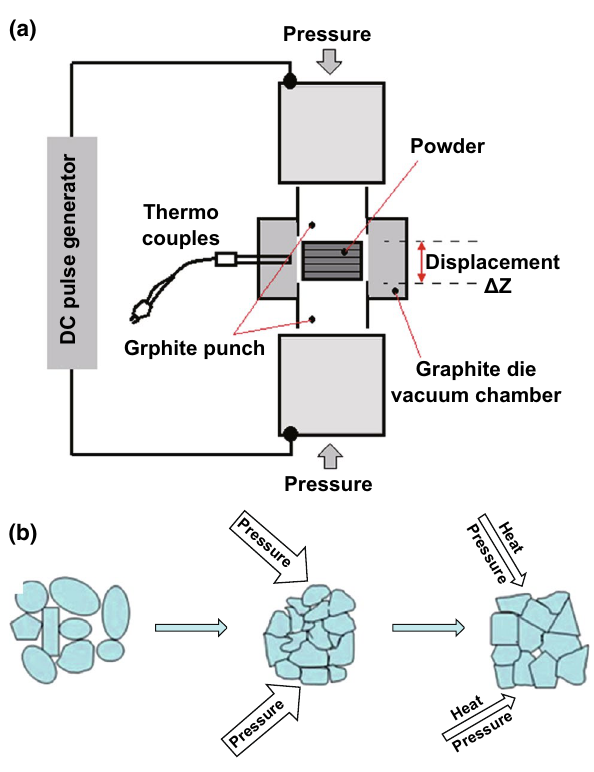
Fig. 8 a Schematic representation of SPS equipment [112]. b The formation mechanism of WC sintered under high pressure [18]. Fig‑ ure panels reproduced from Ref. [112] with permission from Taylor & Francis copyright 2007, Ref. [18] with permission from